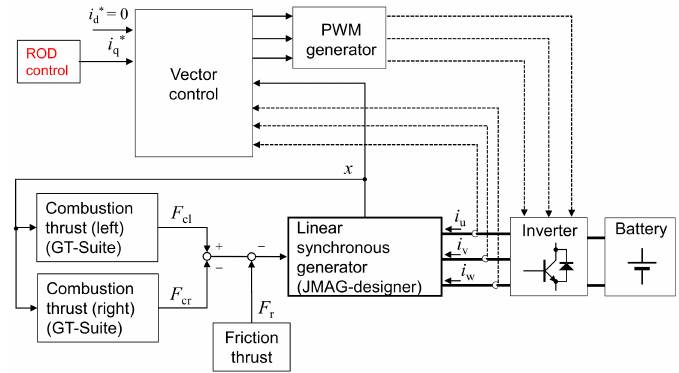
Figure 3. Block diagram for energy flow